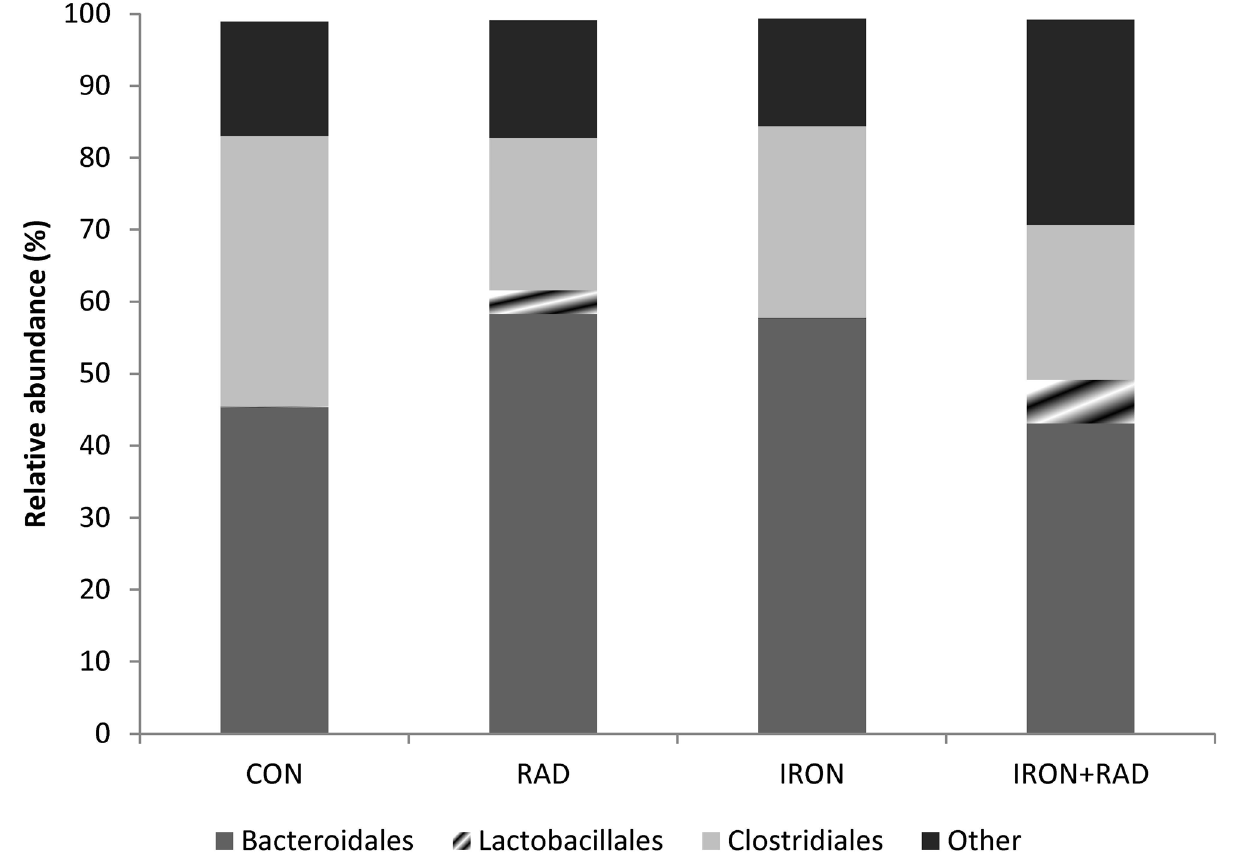
Fig 1. Relative abundance (%) of bacterial taxa at the order level in the feces of rats resulting from exposure to high dietary iron or low LET radiation (Experiment 1). Actual values in S2